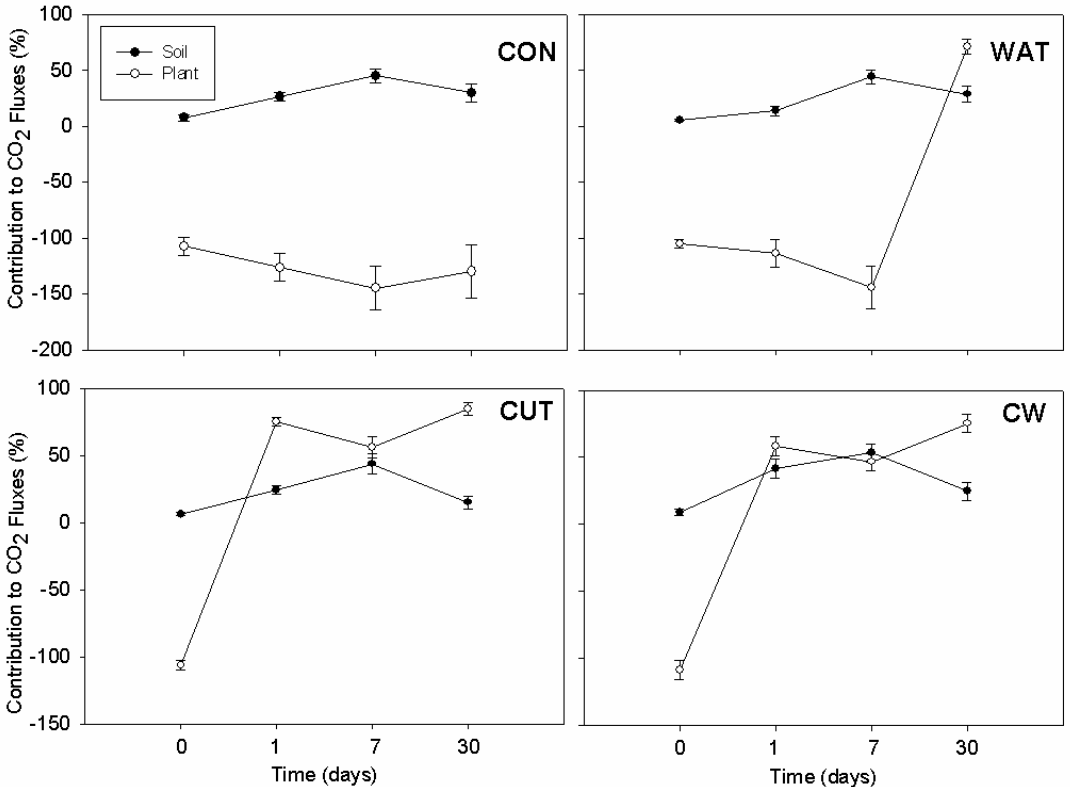
Figure 2. Percentage contribution of the soil or plant-related CO 2 fluxes to the total mesocosm CO 2 fluxes, in the different treatments at varying sampling times (0, 1, 7, and 30 days), in experiments conducted on G. tinctoria at UCD’s Rosemount Environmental Research Station glasshouse, Dublin, Ireland, July–August 2017 (n = 12; mean ± SE). Legend: CON = control plants subjected to normal watering; WAT = plants subjected to flooding; CUT = plants that had the leaves cut from the petioles but were watered normally; CW = plants where leaves were removed and were also subjected to rhizome flooding. Note: negative numbers indicate absorption/uptake of CO 2 , whereas positive numbers indicate emissions of CO 2 .